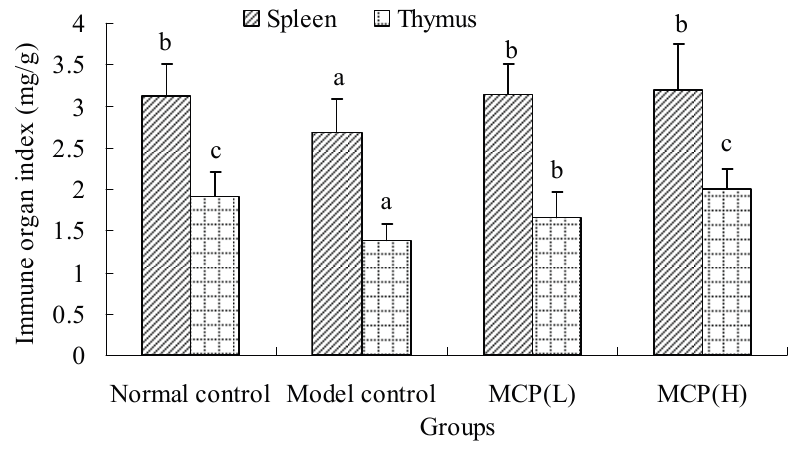
Figure 1. Effects of MCP on spleen and thymus indexes in immunosuppressed mice. The spleen/thymus index was measured as the ratio of the spleen/thymus weight (mg) to bodyweight (g). Values are presented as means ± SD (n = 12). The statistical significance of differences among the groups was evaluated using ANOVA, followed by the S-N-K test. Different letters for same index among the groups represent significant differences at p <